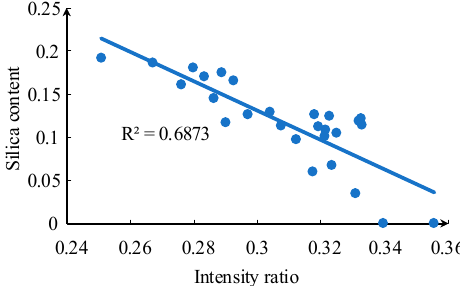
Figure 13. Intensity ratio of Si I 300.8 nm to O II 440.5 nm for samples with different silica filler content.